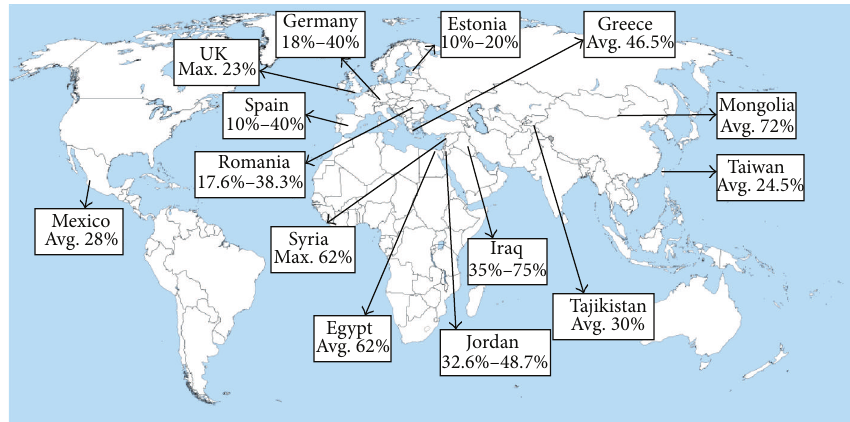
Figure 1: Efficiency of solar tracker works reported around the world.